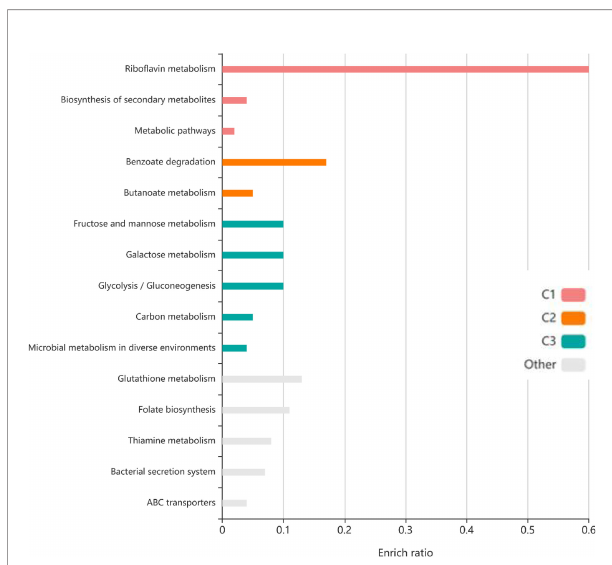
FIGURE 5 | The KEGG pathway enrichment analyses of 71 protein. Top ten KEGG pathways of proteins, each row represents an enriched function, and the length of the bar represents the enrich ratio. The color of the bar represents different clusters.